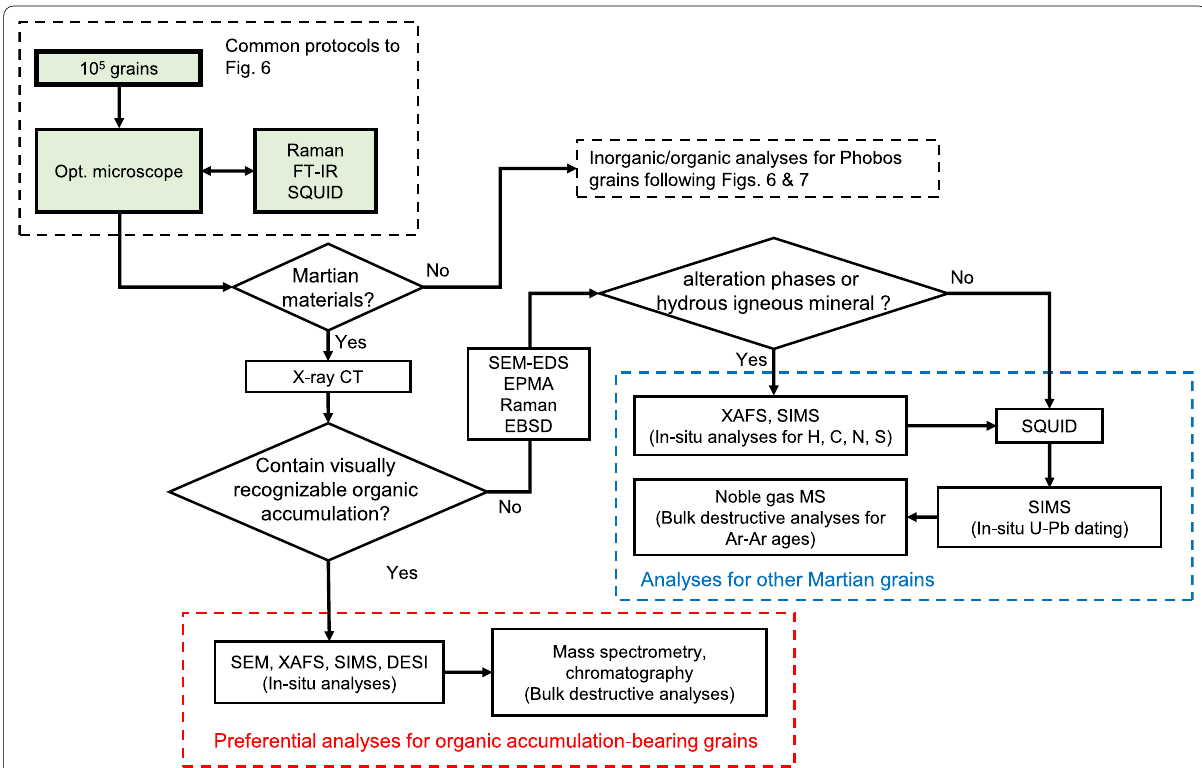
Fig. 8 Working flow of Martian material